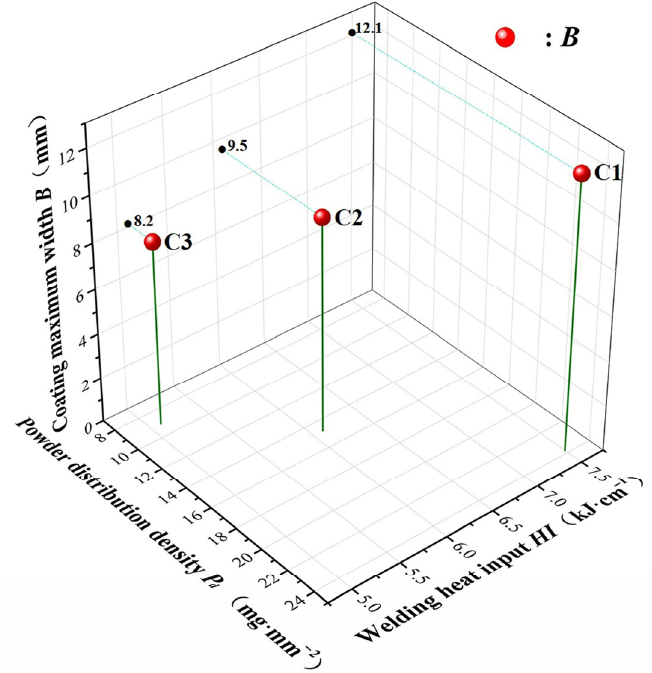
Figure 3. Influences of welding heat input (HI) and powder distribution density (P d ) on coating maximum width (B).